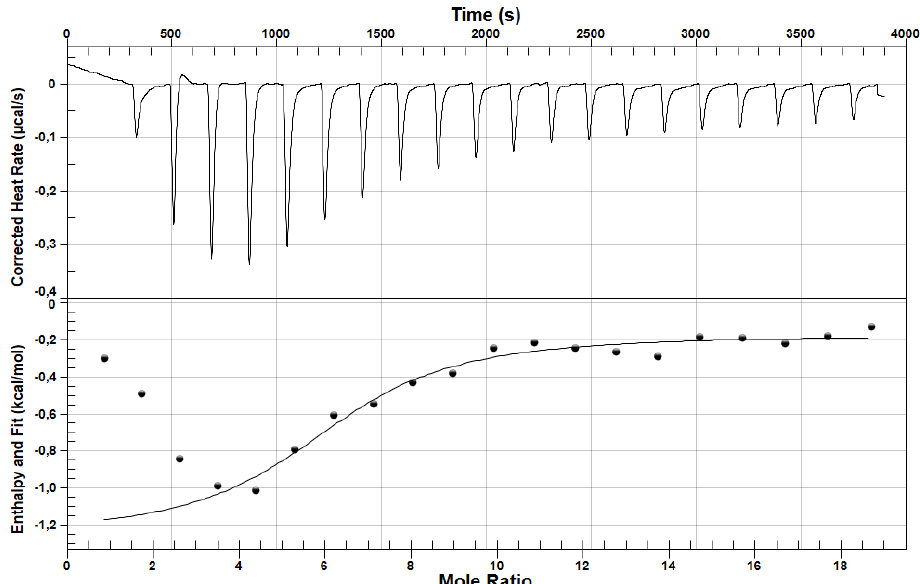
Figure 3. A nanoITC thermogram of albumin in the presence of LOS (LOS:HSA ~1:1 ÷ ~19:1 molar ratio); the upper figure shows the raw heat data obtained from the consecutive injections while the lower figure presents binding isotherm created by plotting areas of the heat peak in relation to the molar ratio of losartan to albumin. The lines present the best fit of the models used. T = 298 [K].